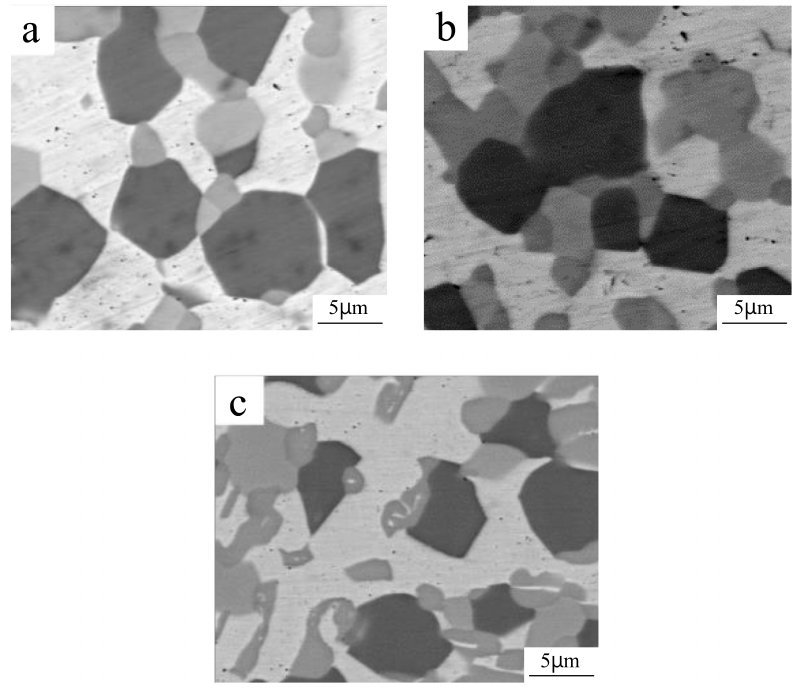
Figure 6. Backscattered electron images of the three composites: ( a ) Nb-3SiC; ( b ) Nb-5SiC; ( c )